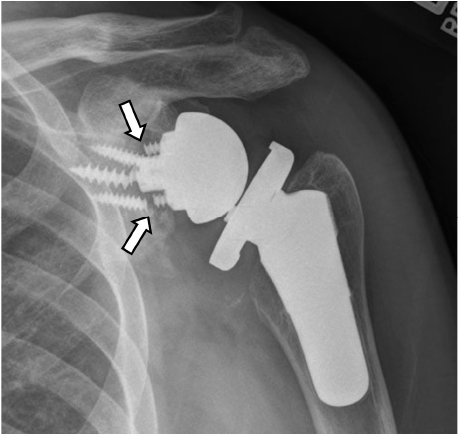
Figure 22. Dislocated RTSA. ( A ). Frontal radiograph shows the humeral component displaced superiorly (arrow denotes force direction). ( B ). Scapular Y view shows the humeral component displaced anteriorly (arrow denotes force direction).